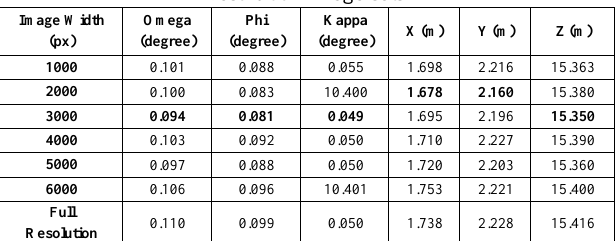
Table 3. The accuracy of the exterior orientations of